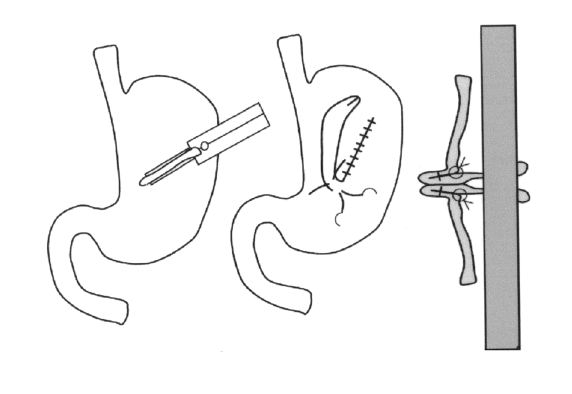
Figure 3 – Schematic drawing of surgical technique in the con- trol